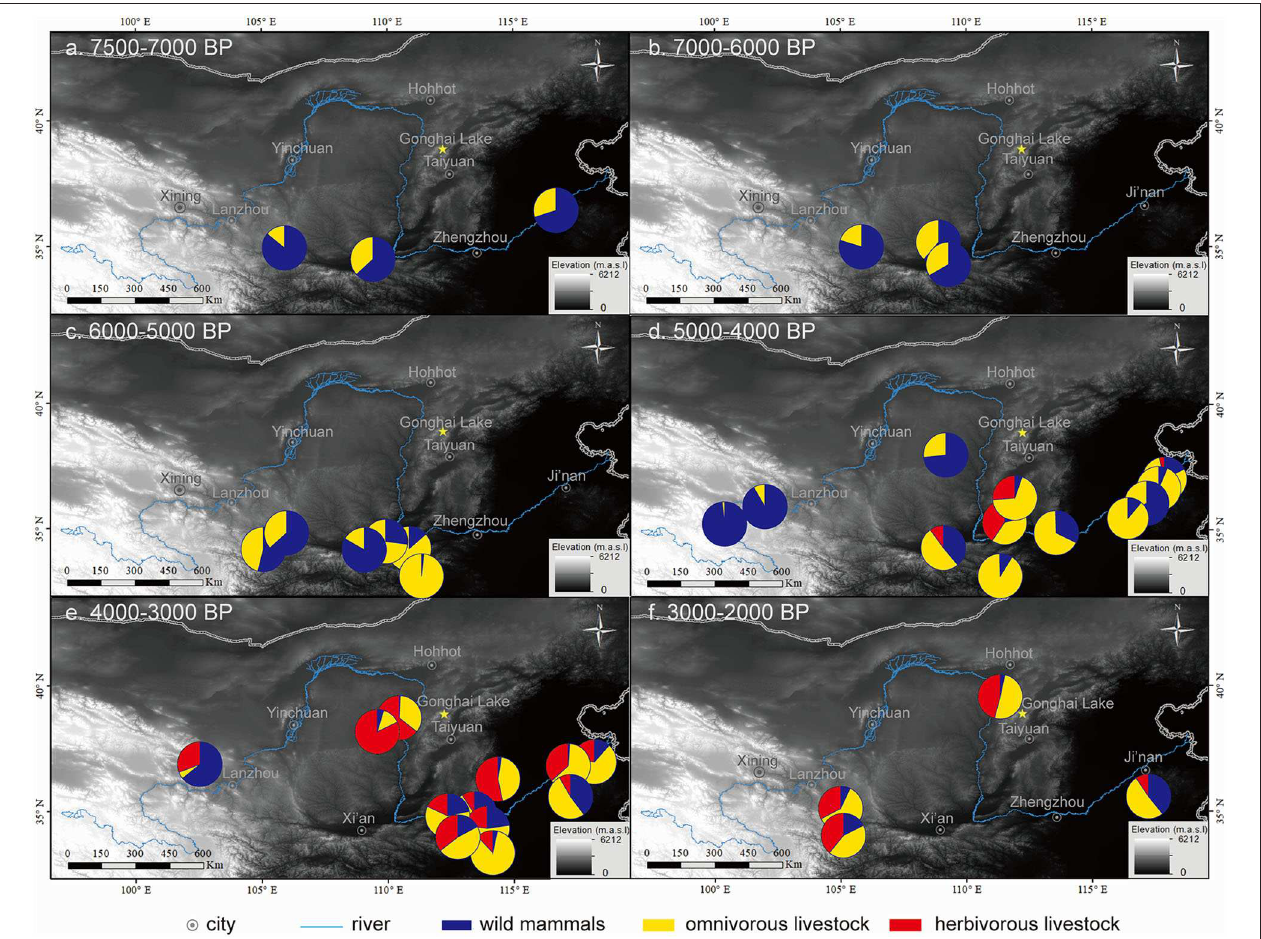
FIGURE 2 | Spatial-temporal patterns of animal assemblages (Number of Identified Specimen) from sites dating to 7500–2000 BP in Yellow River Valley. (a) Animal assemblages from sites dating to 7500–7000 BP. (b) Animal assemblages from sites dating to 7000–6000 BP. (c) Animal assemblages from sites dating to 6000–5000 BP. (d) Animal assemblages from sites dating to 5000–4000 BP. (e) Animal assemblages from sites dating to 4000–3000 BP. (f) Animal assemblages from sites dating to 3000–2000